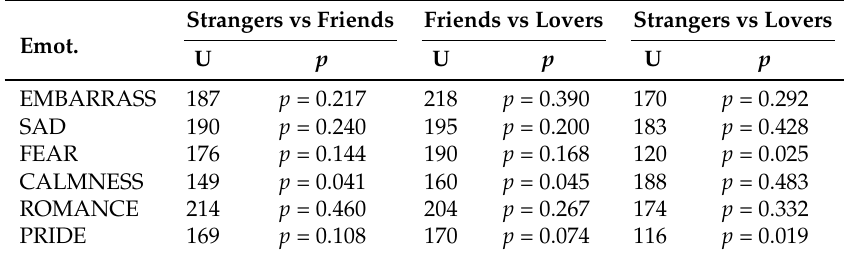
Table 2. Results of the Mann–Whitney tests to compare the distribution of the copresence synchrony between the different relationship